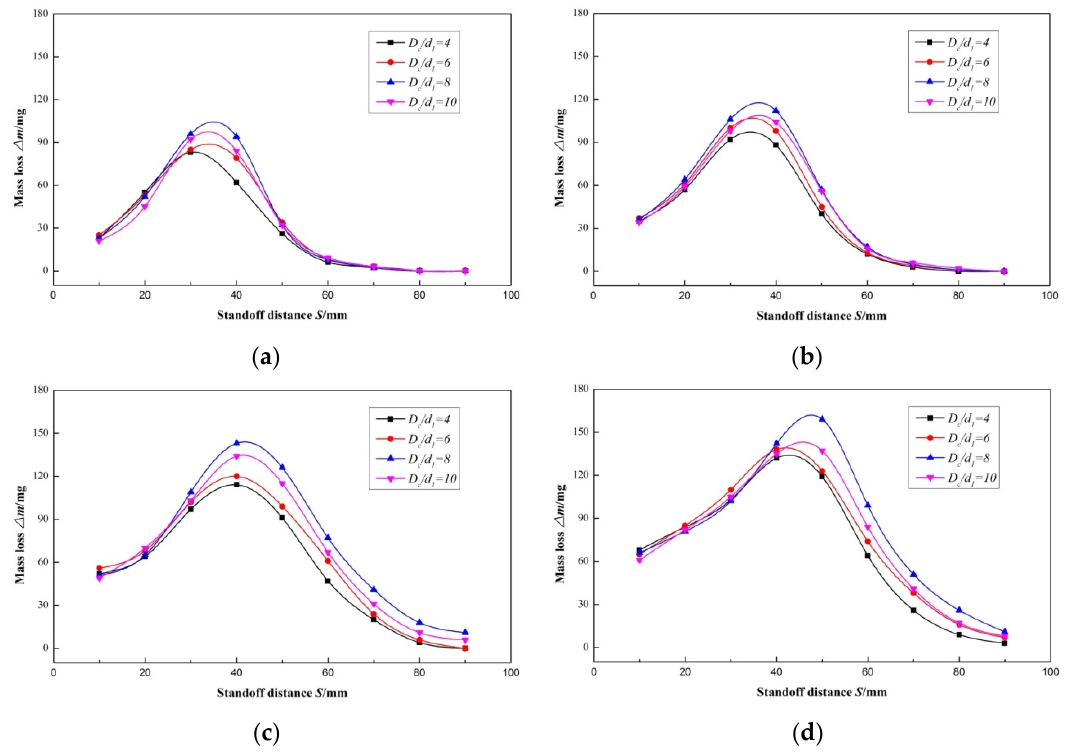
Figure 14. Mass loss as a function of standoff distance under different cavity diameter. ( a ) P o = 10 MPa; ( b ) P o = 15 MPa; ( c ) P o = 20 MPa; ( d ) P o = 25 MPa.